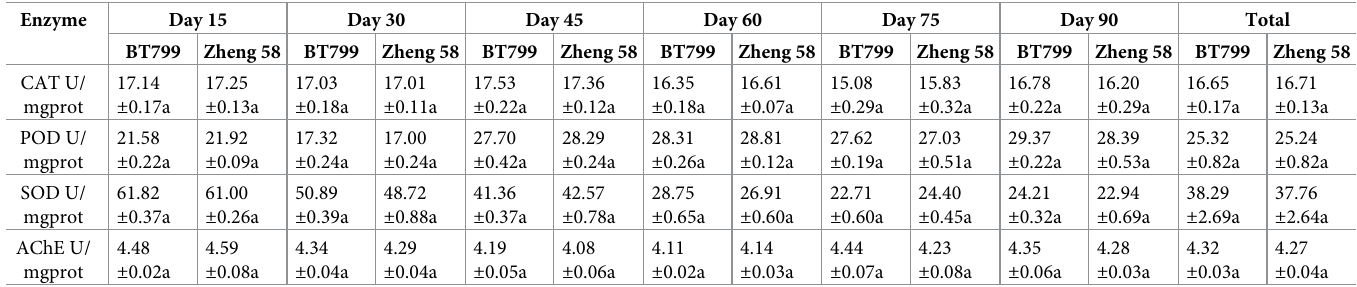
Table 1. Enzyme activity of E . fetida fed with two different maize